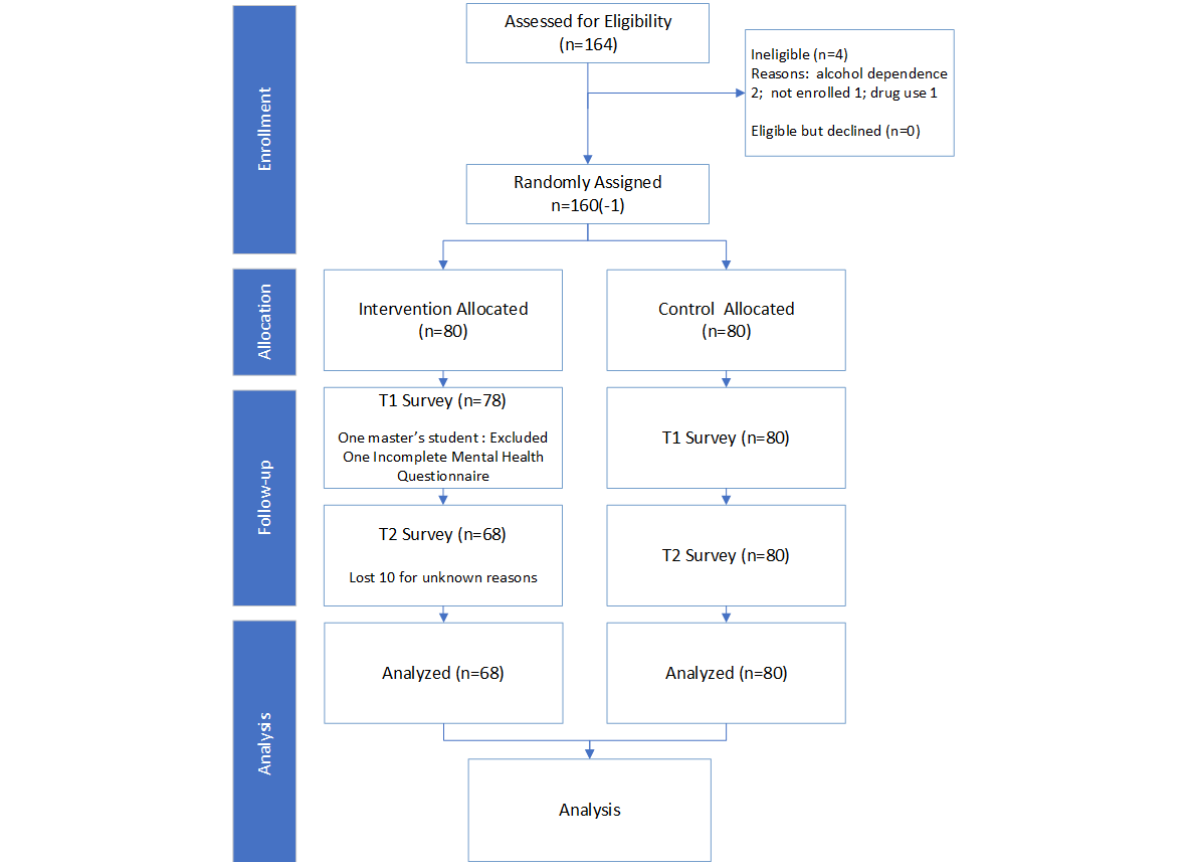
Figure 2. The CONSORT flow diagram for the